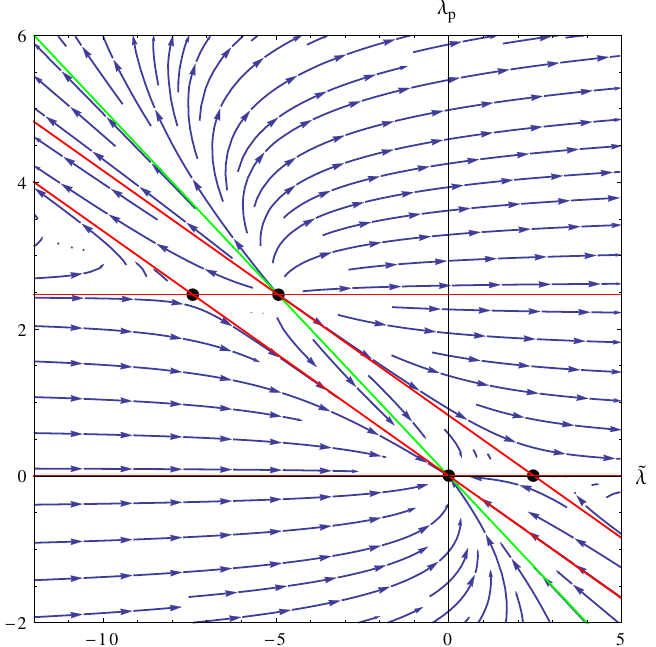
(cid:16) (cid:17) ~ (cid:21); ~ (cid:21) -plane. Arrows point towards the IR , black p